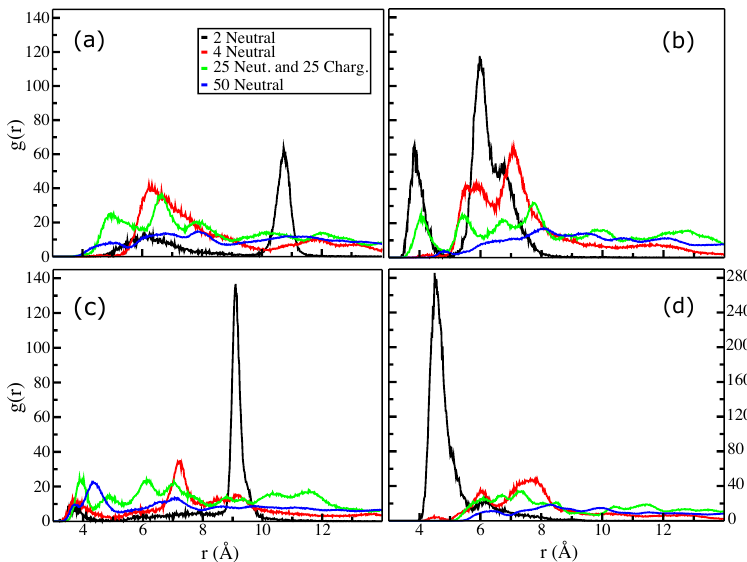
Figure 3. Size dependence of the radial distribution function (RDF). The planes of eumelanin are shown in Figure 1a. RDFs between ( a ) the COMs of the ICAQ moieties, ( b ) the DHICA moieties, and ( c ) the PTCA moieties. ( d ) RDFs between COMs of the DHICA eumelanin molecules. The systems are two uncharged, four uncharged, 25 uncharged and 25 charged, and fifty uncharged eumelanins; see details in Table